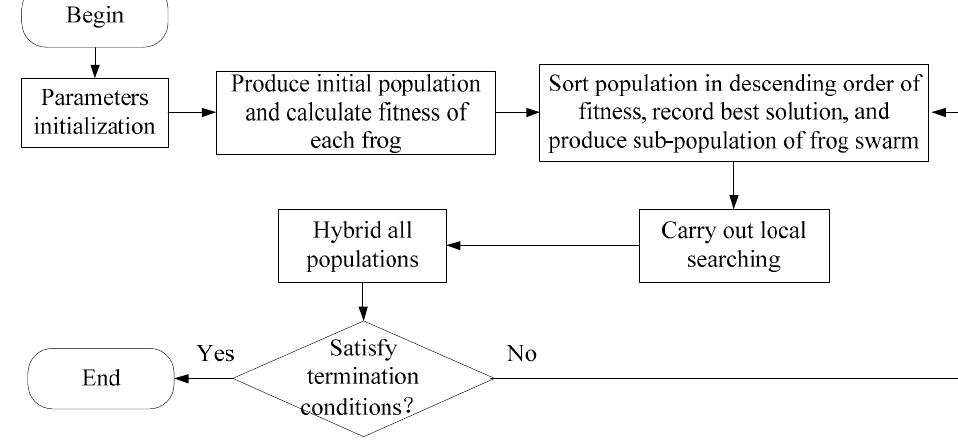
Figure 3. Flowchart of the shuffled frog leaping algorithm.